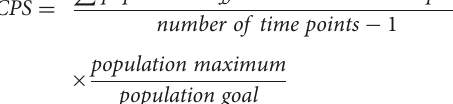
5,000: P population differences between time points CPS = number of time points − 1 population maximum × population goal